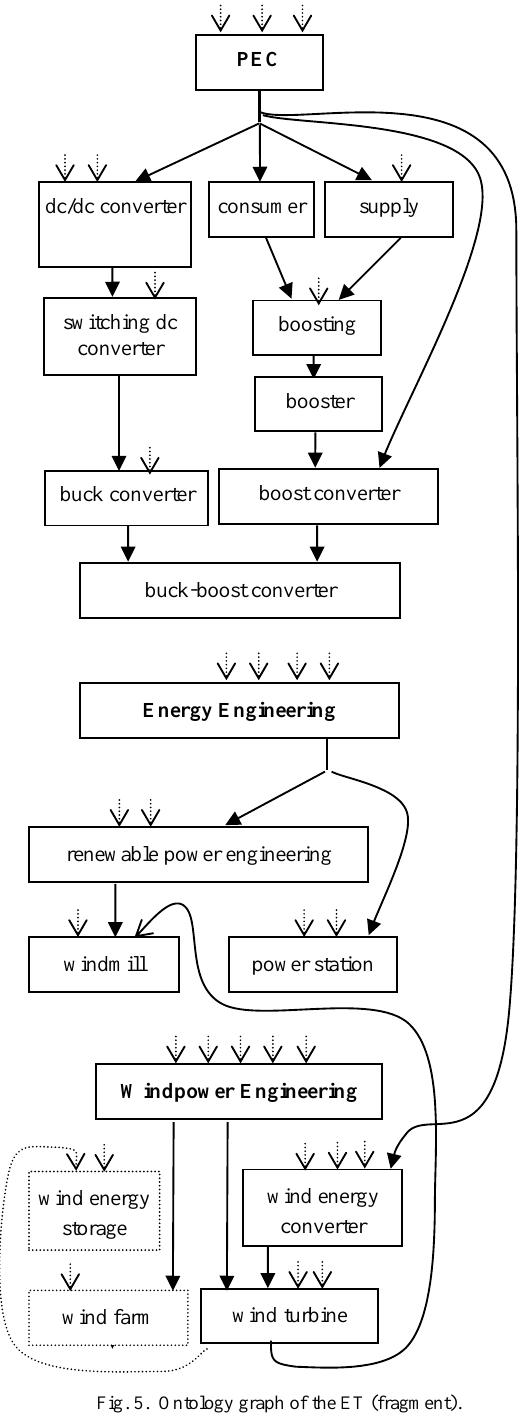
Fig. 5. Ontology graph of the ET (fragment). Here, the concept of windmill is defined by means of the term wind turbine from the discipline Windpower Engineering , which may be recommended for inclusion in the knowledge domain as an intermediate